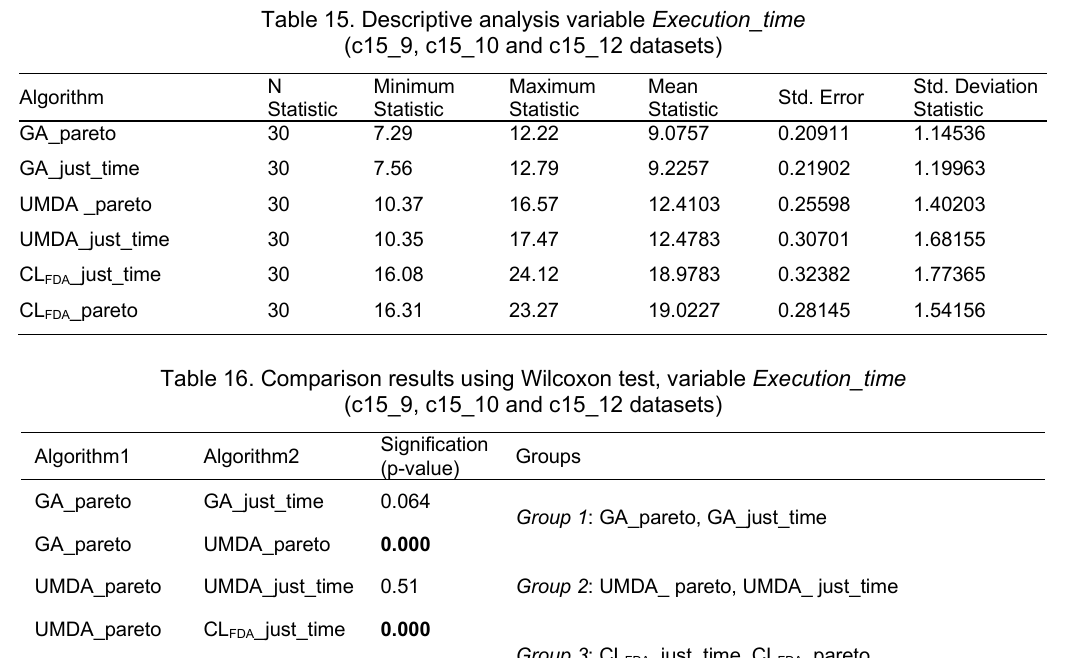
Table 15. Descriptive analysis variable Execution_time